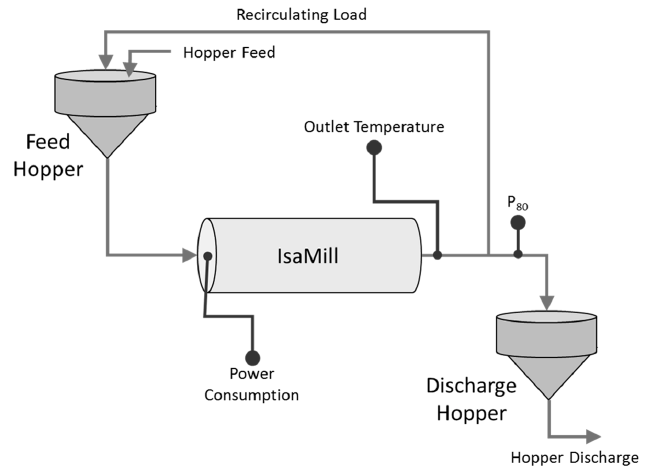
Figure 9. Flow diagram of the IsaMill grinding circuit, showing the measuring points of the power, temperature, and P 80 particle size (after Aldrich and Napier [37]).